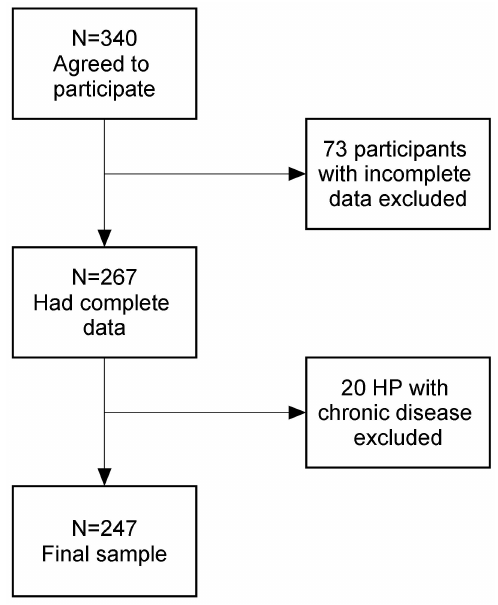
Figure 1. Data collection and